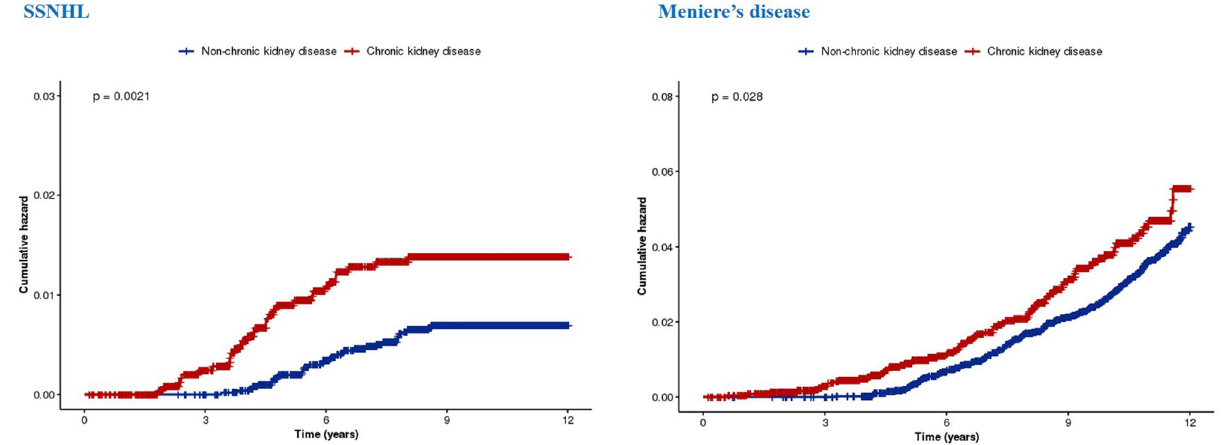
Figure 2. Risk of development of SSNHL and Ménière’s disease among individuals with and without chronic kidney disease. SSNHL, sudden sensorineural hearing